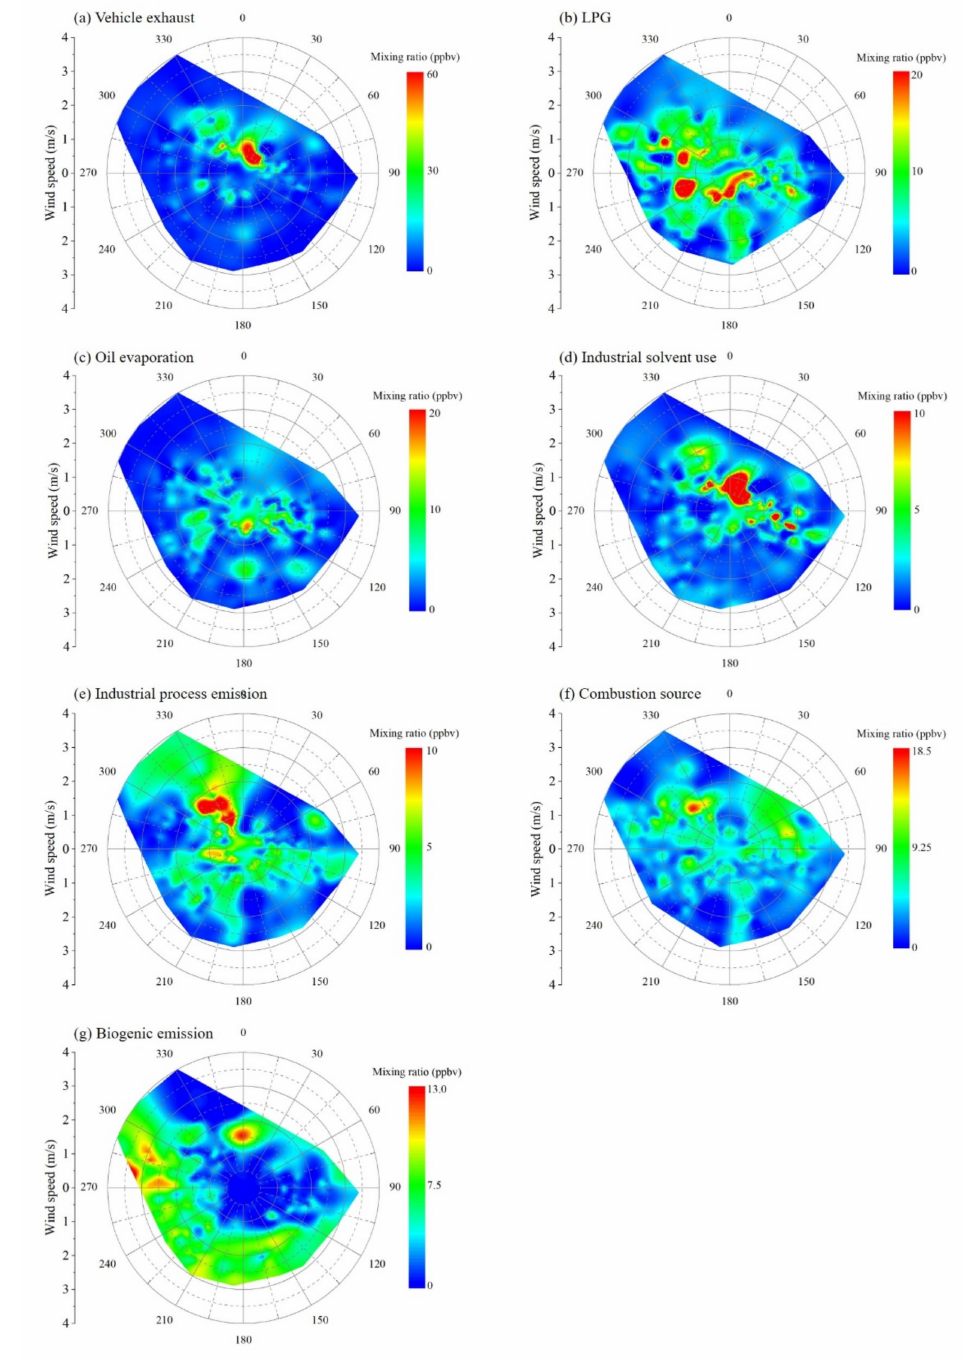
Figure 9. The distributions of mixing ratio of each source in wind direction and speed. The hotspot of vehicle exhaust emissions was mainly concentrated in the northerly direction with wind speed <1 m s − 1 , possibly related to vehicle exhaust emission in central urban areas of Guangzhou and Panyu district under northerly winds. There were two peaks for LPG emission in the west–southwest and west–northwest with wind speed of 1.5 m s − 1 , as well as a strip southeast of the Panyu site. For oil evaporation, the hotspot was concentrated in a southern direction with low wind speed (<0.5 m s − 1 ). Similar to vehicle exhaust, industrial solvent use emissions were mainly centered on the north– northeast region with wind speed <1 m s − 1 , and several hotspots were also observed with relatively high wind speed (2–3 m s − 1 ), indicating transport from other cities